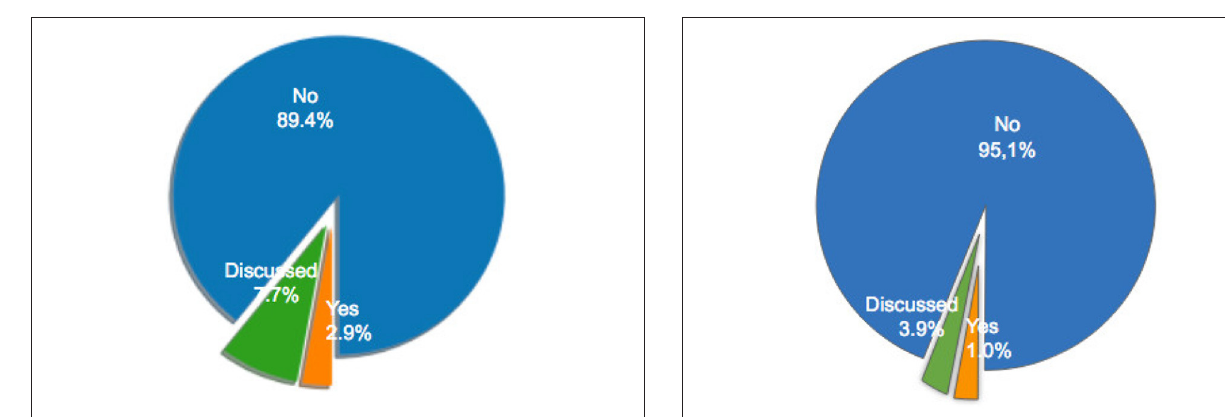
FIGURE 11 | Distribution of the application of the sensitivity criteria.